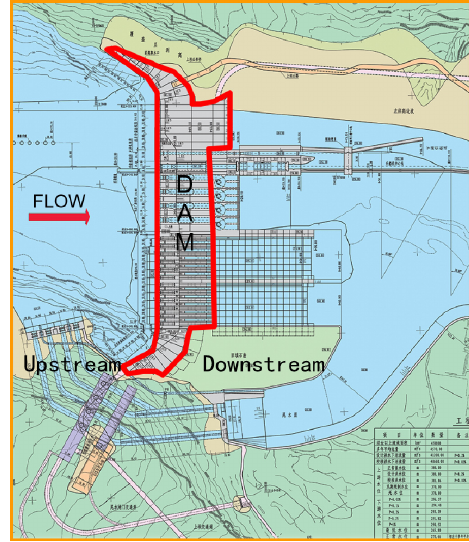
Figure 4. Planform of the dam.